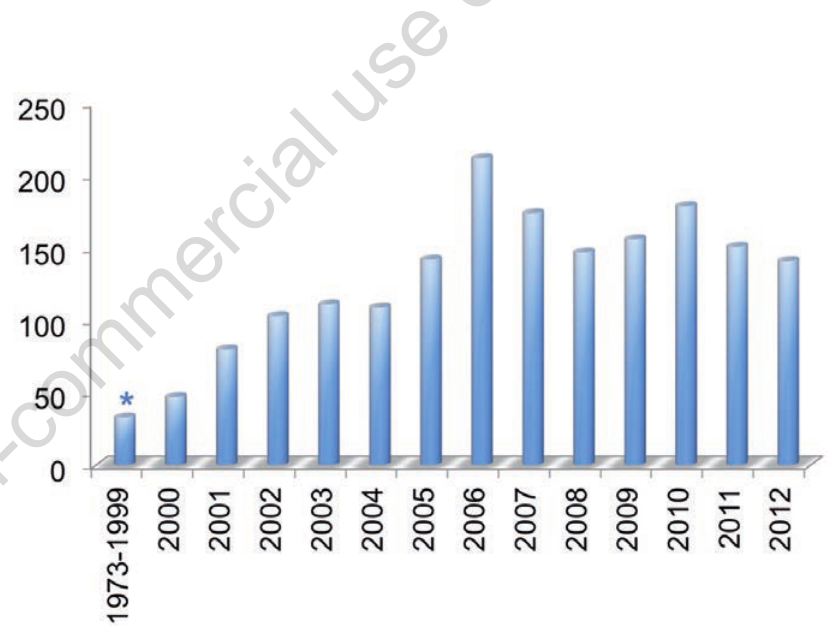
Figure 1. The number of papers on Anderson-Fabry disease is significantly increased since the advent of enzyme replacement therapy, in 2001.